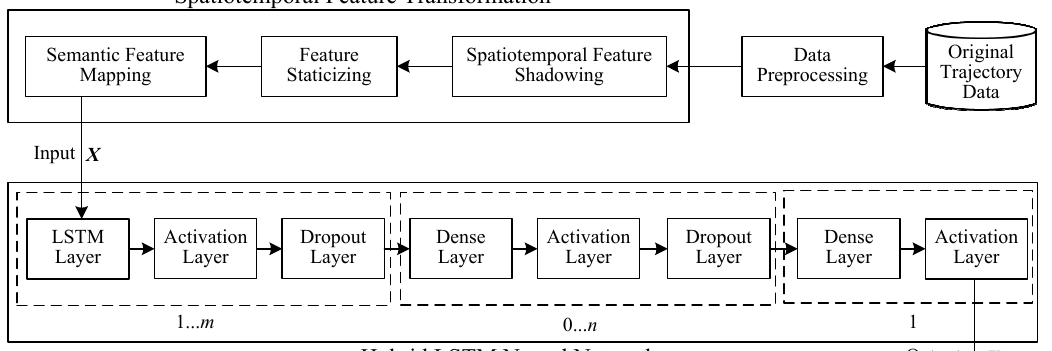
Figure 1. Our proposed algorithm.